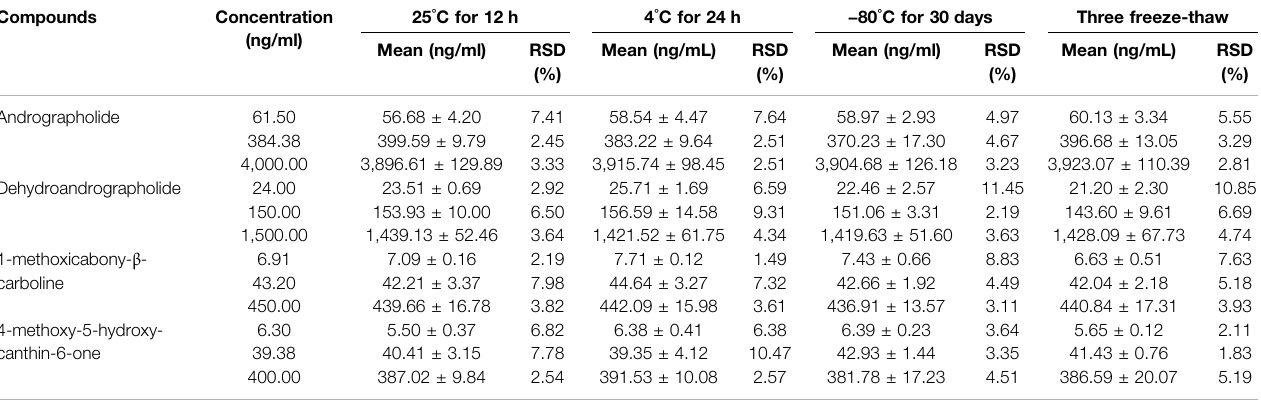
TABLE 5 | The stability test of four compounds in rat serum ( n = 6). Compounds